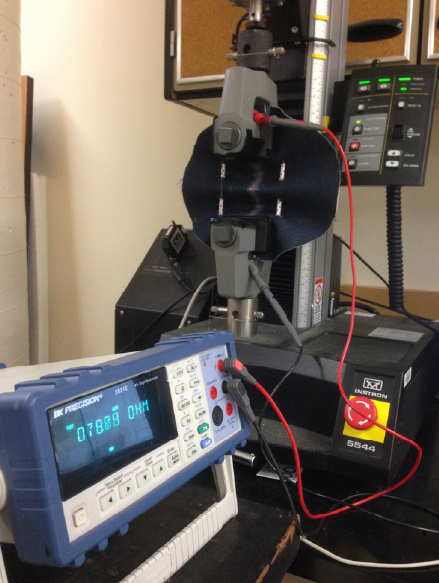
Figure 3. Denim bend test setup: denim sample clamped between Instron plates and connected to digital multimeter.